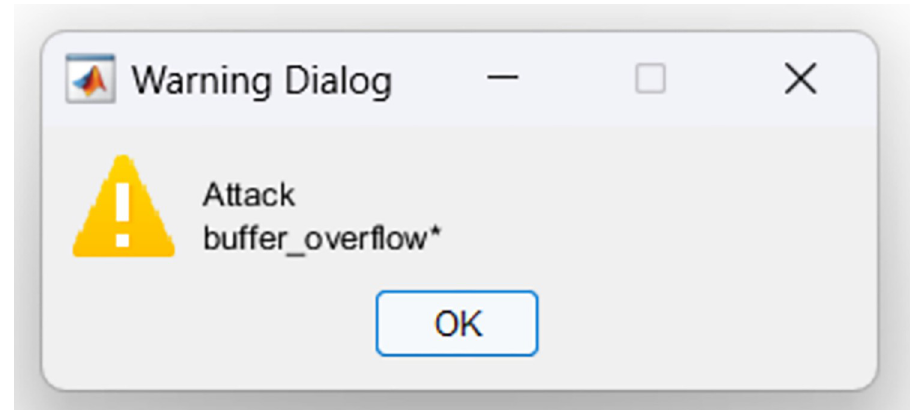
Fig 4. Warning dialog box of proposed